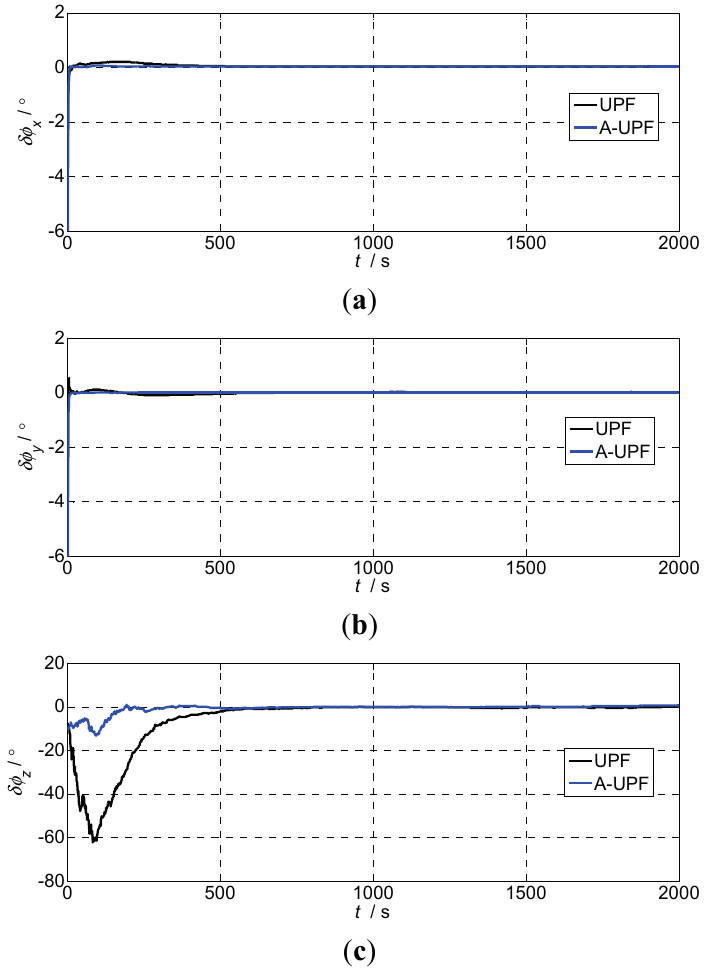
Figure 1. The alignment errors of large azimuth misalignment angle ( [ ] (0) 1 = ° ° ° ): ( a ) Pitch errors; ( b ) Roll errors; ( c ) Heading errors. Table 1. Determining the statistical properties of the noise are the statistical results of the alignment.